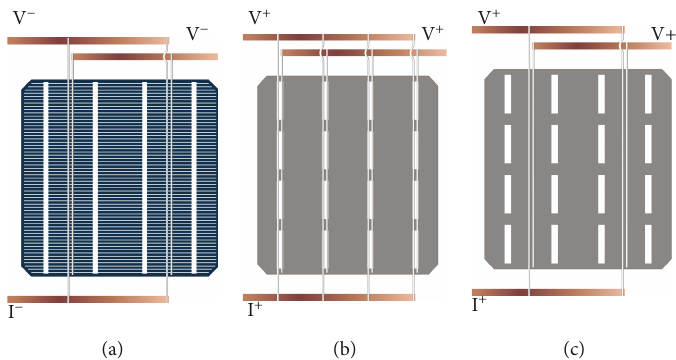
Figure 5: Schematic of the test modes to analyze the wire contact resistance to di ff erent parts of the cell electrode. (a) Fingers, (b) back busbars, and (c) Al-BSF.